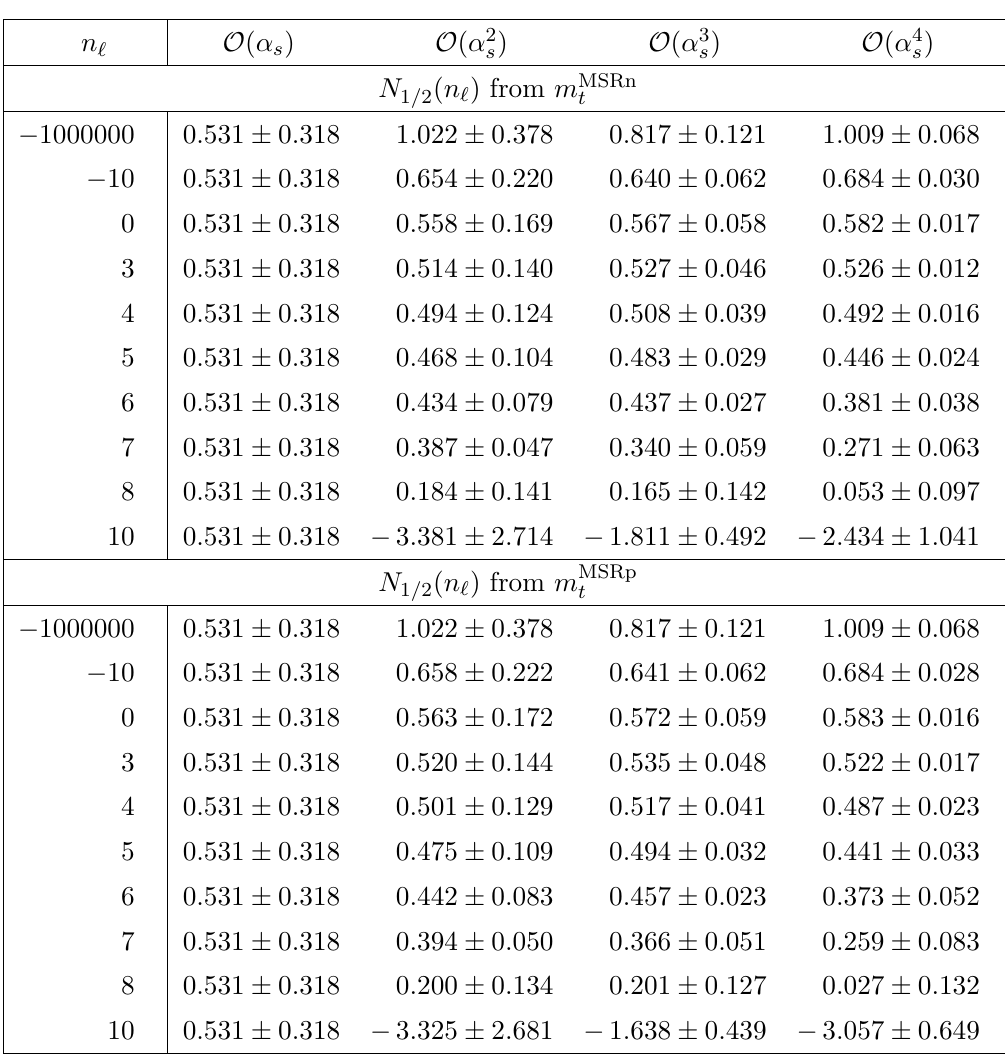
Table 1. N ( n ‘ ) for the natural and practical heavy quark MSR masses. The results are given 1 = 2 for di(cid:11)erent theoretically interesting values of n ‘ including contributions from one to four loops. The errors shown are obtained from (cid:21) variations in the interval [0 : 5 ; 2] and the central values are the mean value of the respective maximal and minimal values obtained in that